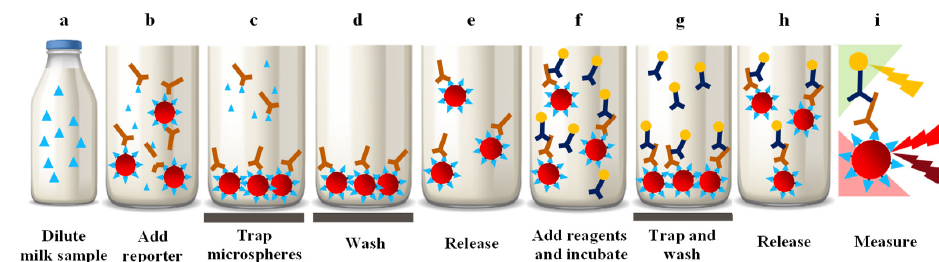
Figure 2. Sample analysis scheme for the competitive microsphere immunoassay. Milk samples are diluted ( a ), after which the β -casein-specific microspheres and β -casein-specific antibodies are added to the diluted sample ( b ); after incubation, the microspheres are trapped by a magnet ( c ) and the milk sample and unbound antibodies are removed ( d ). Next, the microspheres are released ( e ) and the GAC-RPE reporter antibody is added ( f ). After the second incubation step the microspheres are trapped and washed ( g ), released ( h ), and then measured in the planar array analyzer ( i ), where the microspheres are classified by a red LED illumination, after which the red and far-red fluorescence is recorded and the corresponding reporter signal is recorded after green LED illumination.